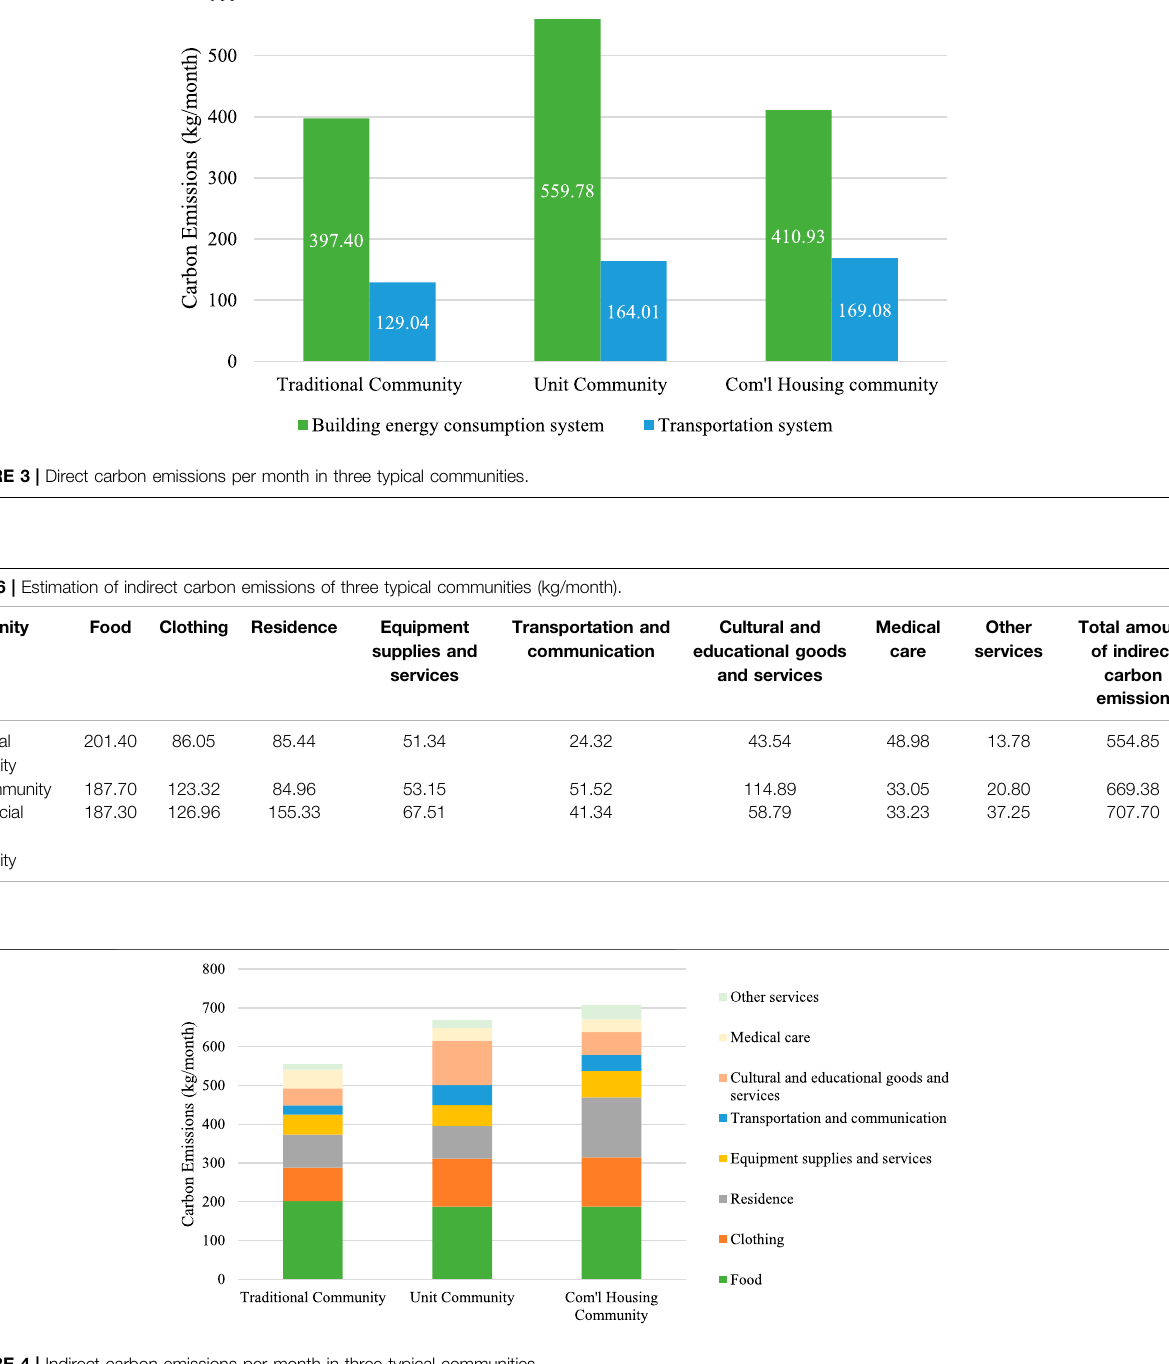
FIGURE 4 | Indirect carbon emissions per month in three typical